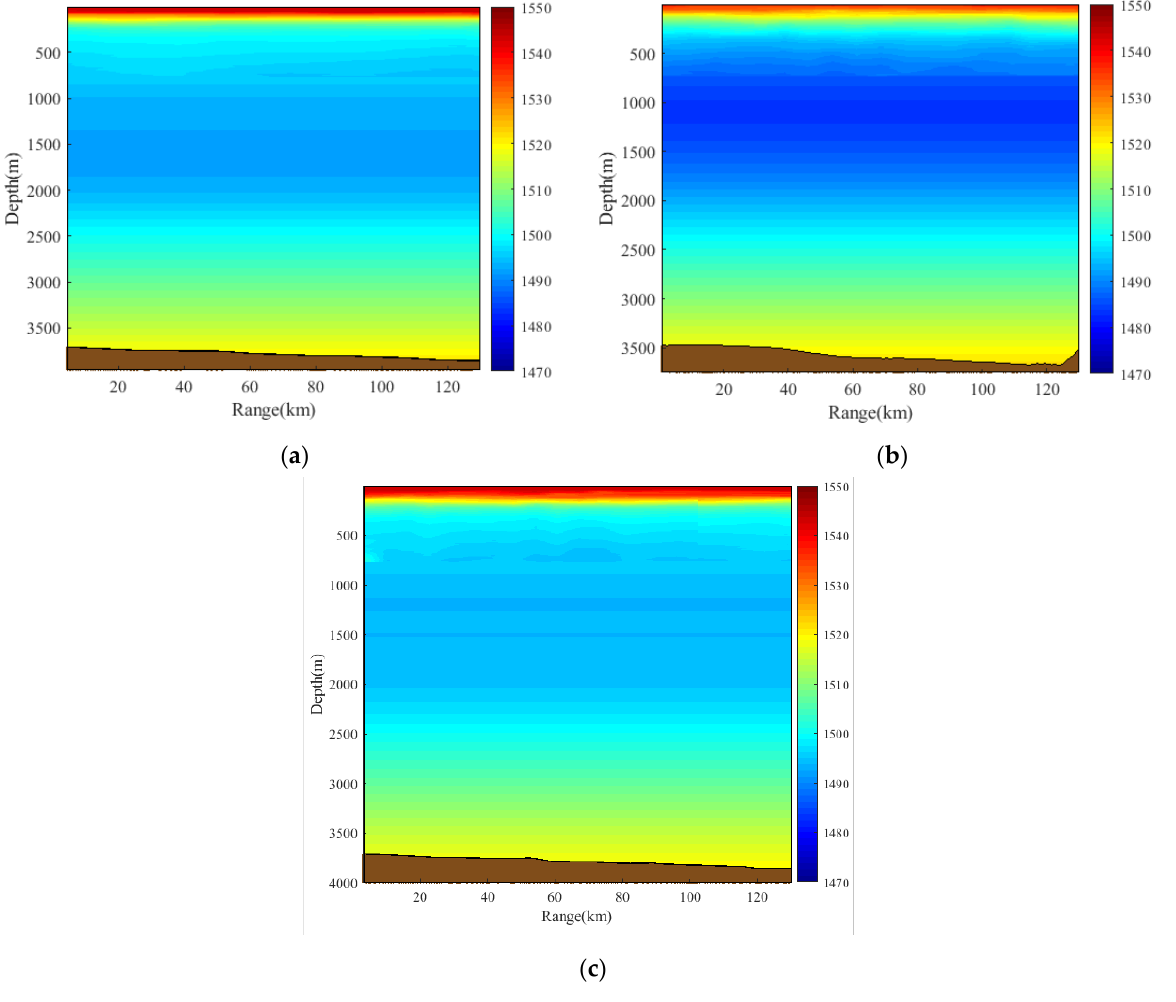
Figure 4. Bathymetry and SSP along the propagation tracks in the EIO 2019 ( a ), SCS 2018 ( b ), and EIO 2021( c ) experiments.